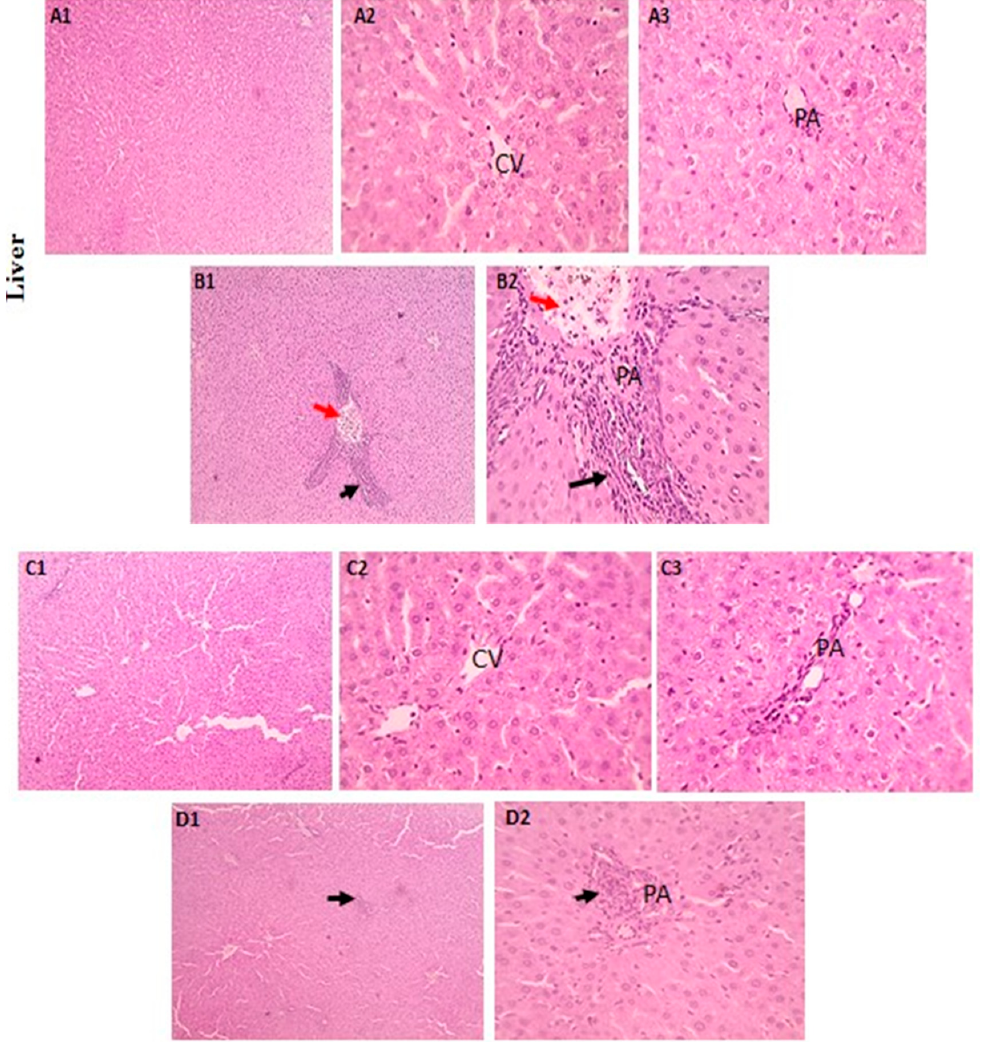
Figure 8. Histopathological examination of liver sections using H&E: ( A1 – A3 ) control and ( C1 – C3 ) liver sections showing the regular arrangement of hepatic cords around central veins (CVs) with normal portal areas (PAs) and sinusoids (H&E, 100 × and 400 × ). ( B1 , B2 ) Liver sections showing portal congestion (red arrows) with massive mononuclear cell infiltration (black arrows) (H&E, 100 × ). ( D1 , D2 ) Liver sections showing mild mononuclear cell in fi ltration (black arrows) in the portal area (H&E, 400×).